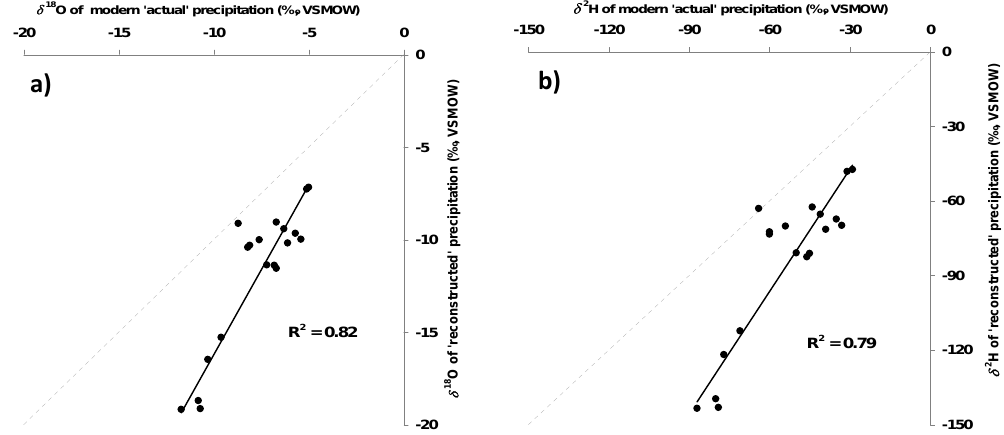
Figure 7. Correlation of biomarker-based reconstructed δ 18 O prec and δ 2 H prec values with modern “actual” δ 18 O prec and δ 2 H prec values (from Bowen,